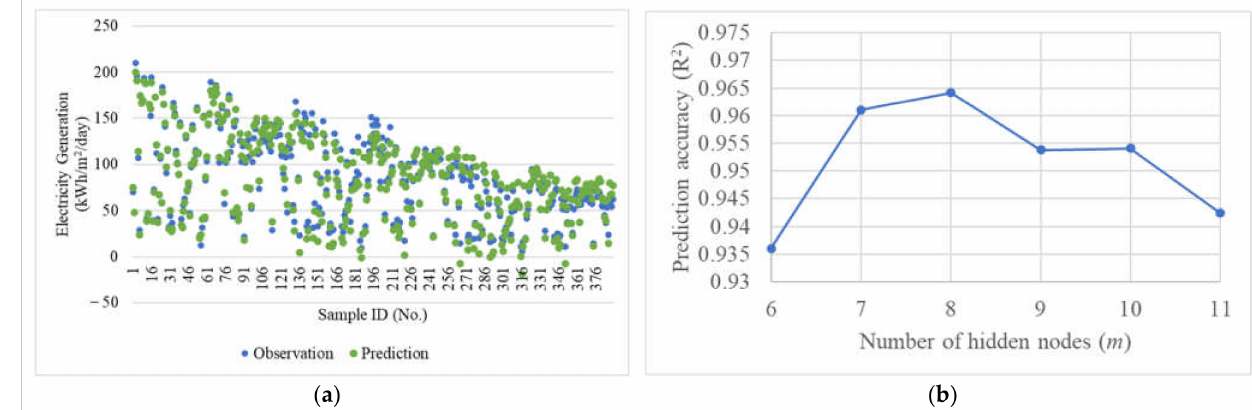
Figure 5. Prediction results: ( a ) deep learning model with eight hidden nodes; ( b ) prediction